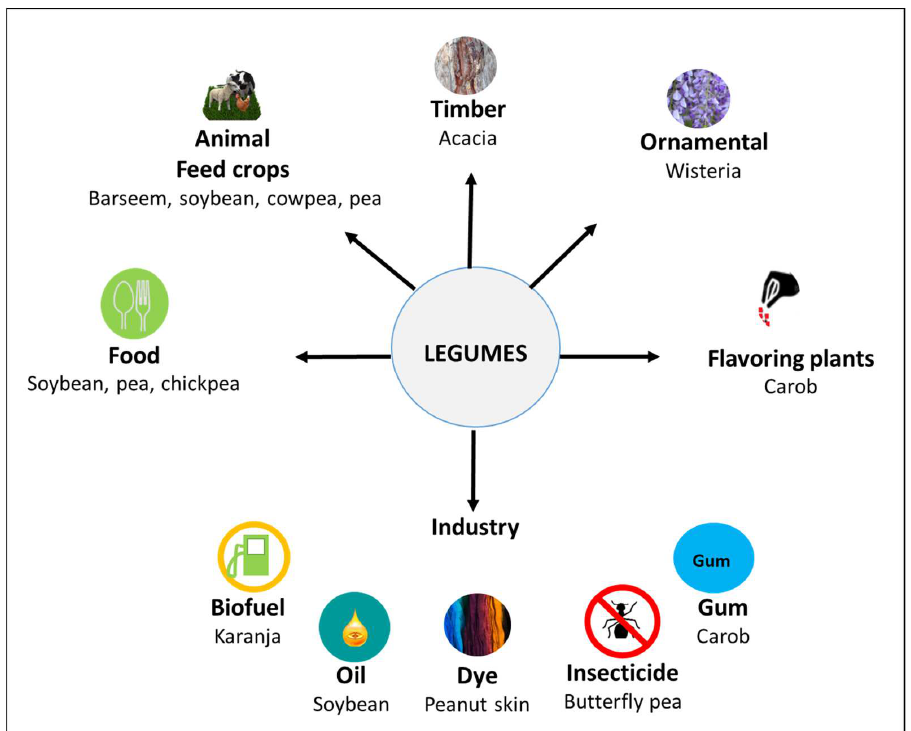
Figure 1. Multi-functional utilization of legumes. The scheme was constructed based on [13–19].